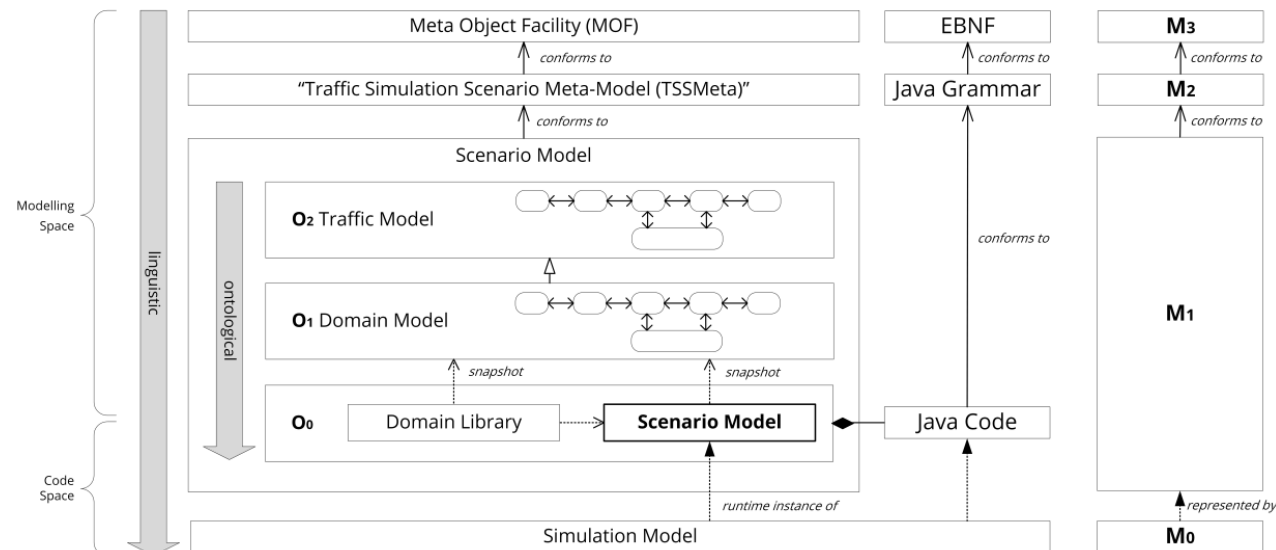
Figure 15. Overview of the model-based multi-layered approach. It incorporates the concepts of MOF [45] and MDA [44], the approach of Atkinson and Kühne to differentiate between linguistic and ontological modeling [49], an adapted version of the 6-layer model of Bock et al. [53] originally targeted at the automotive domain, and a time concept to cope with a discrete time-based simulation and more dynamic environments like those of the maritime domain. In sum, this results in a standardized, holistic, and extensible architecture for the modeling of traffic